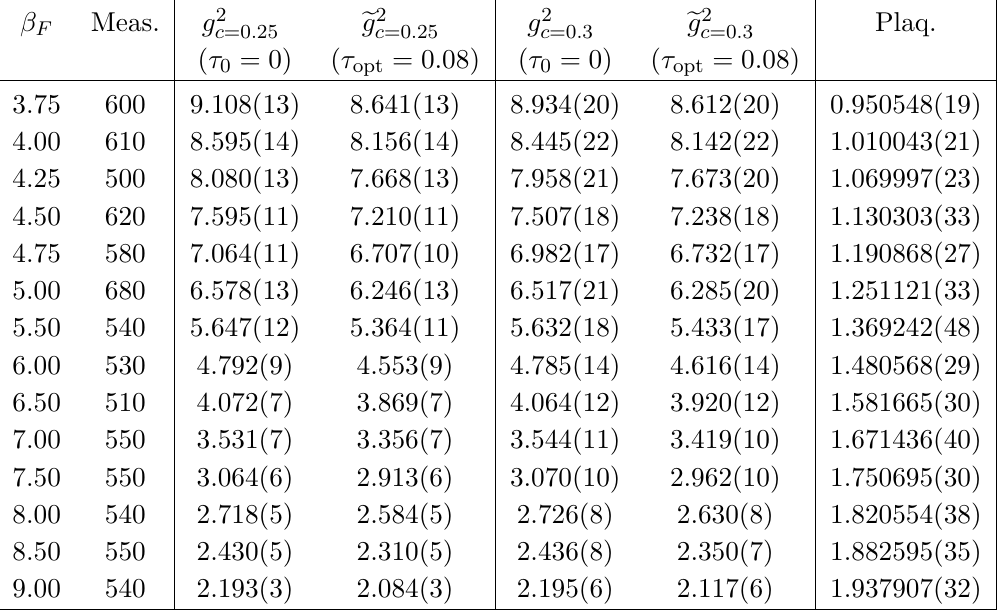
Table 6 . 20 4 lattice ensembles used in this work, with columns as in table